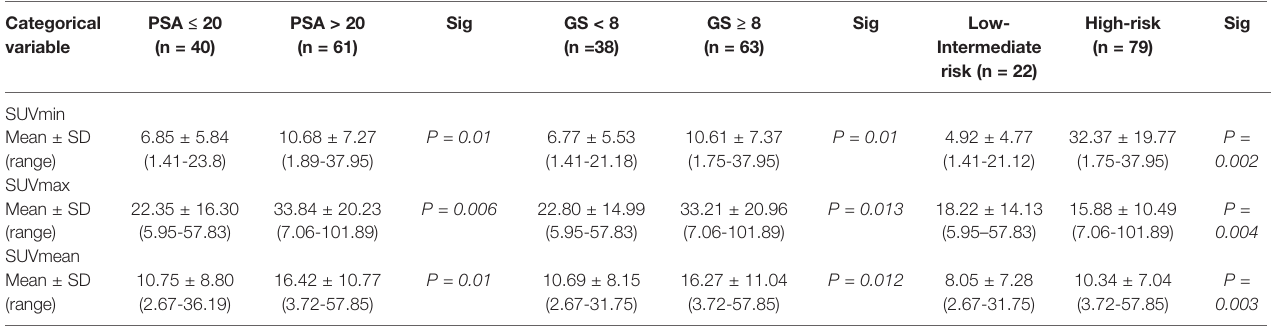
TABLE 2 | 18 F-PSMA-1007 PET/CT parameters of different tPSA, Gleason Score and risk strati fi cation subgroups. Categorical